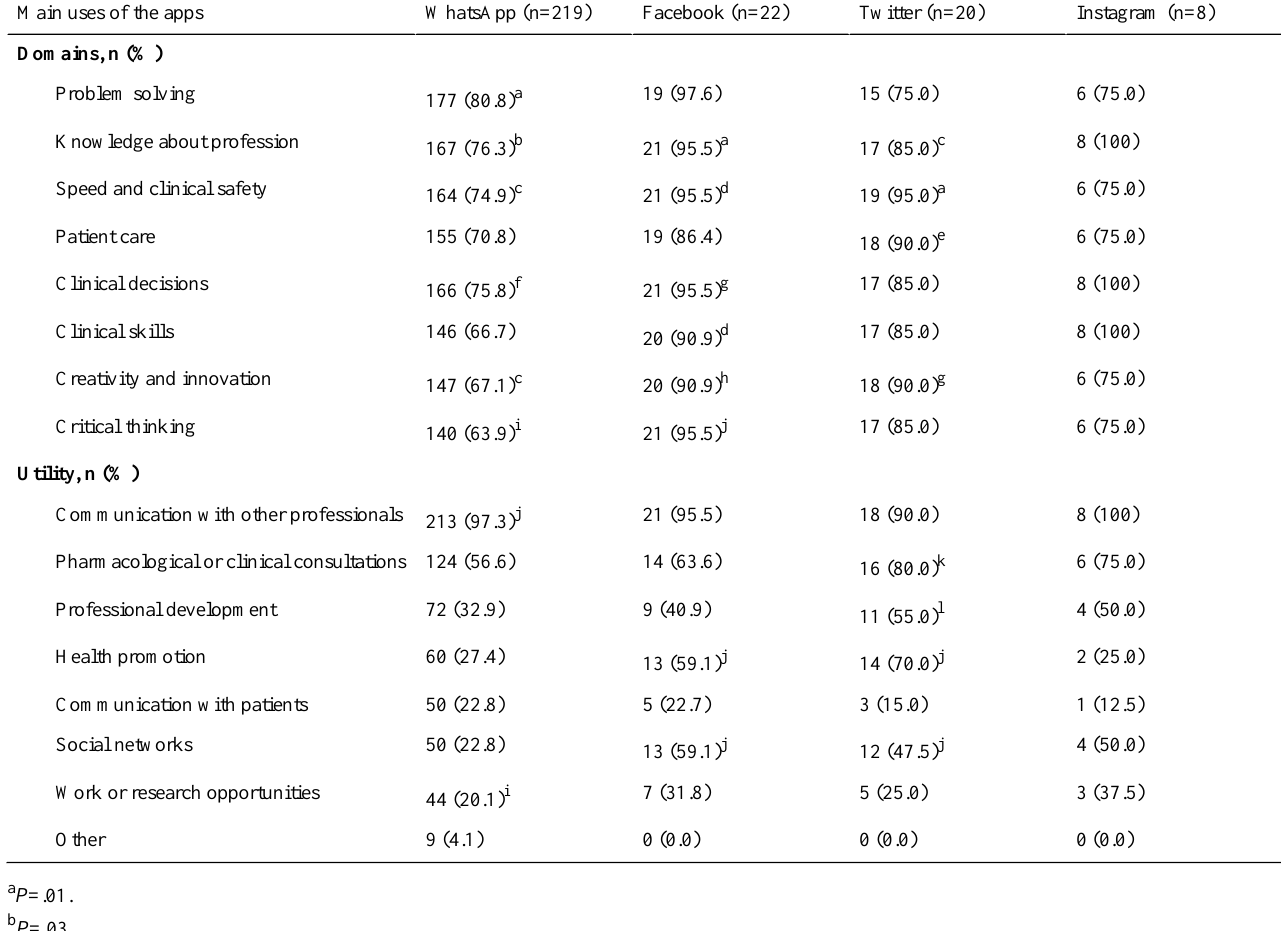
Table 4. Assessment of the impact of 4 apps compared according to the 8 domains